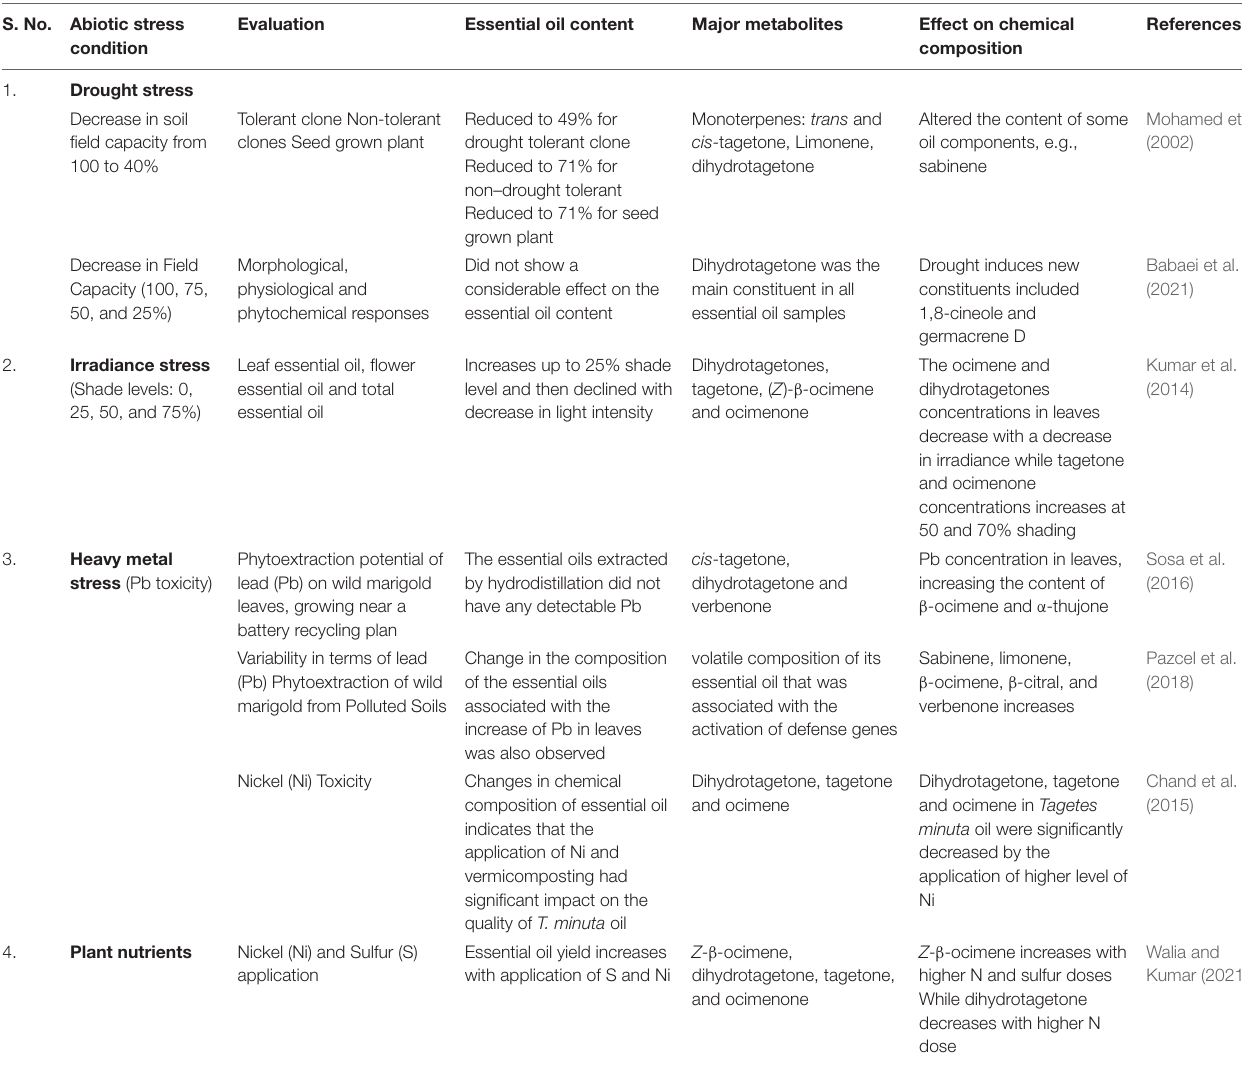
TABLE 1 | Variation in essential oil yield and composition of wild marigold under different abiotic stress